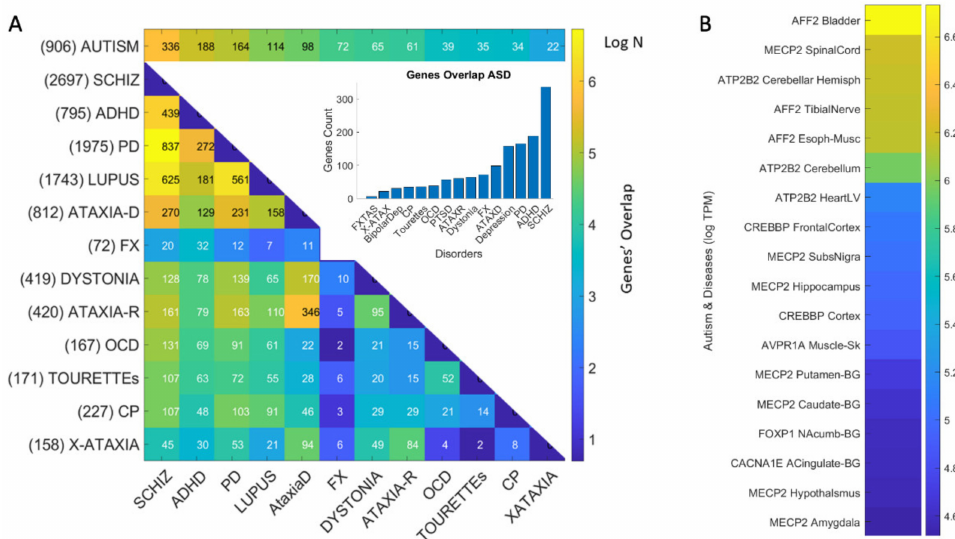
Figure 4. Number of genes common to Autism and selected neuropsychiatric, neurological, and autoimmune disorders. ( A ) Inset shows bar plot tallying the number of genes in each disorder that are also present in the SFARI dataset linking genes to Autism according to a confidence score (see the Section 2) Colormap depicting the number of genes in Autism and each disorder on the top row. Pairwise shared genes between disorder in row i and column j is the number on each entry of the matrix. Color is in log N, where N is the number of genes common to Autism and the disorder, or common to a disorder and another disorder (pairwise intersect.) ( B ) Color bar reflecting the 18 tissues with maximal gene expression and the corresponding gene at the intersection of SFARI-Autism and all shared genes in ( A